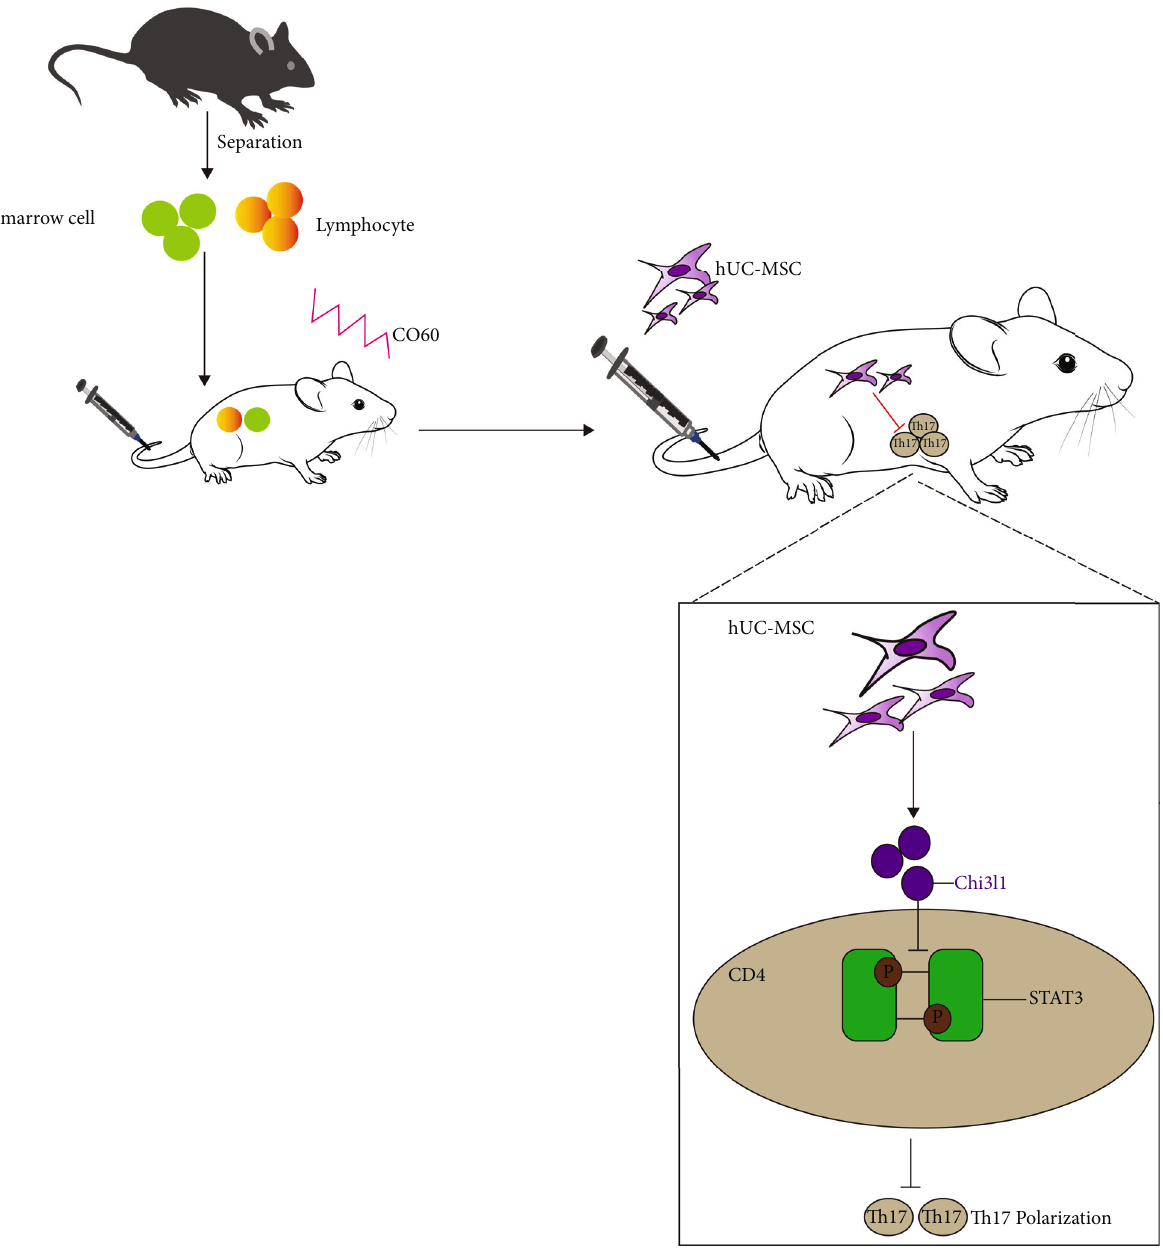
Figure 8: Model of the function and mechanism by which hUC-MSC-secreted Chi3l1 regulates CD4 di ff erentiation into Th17